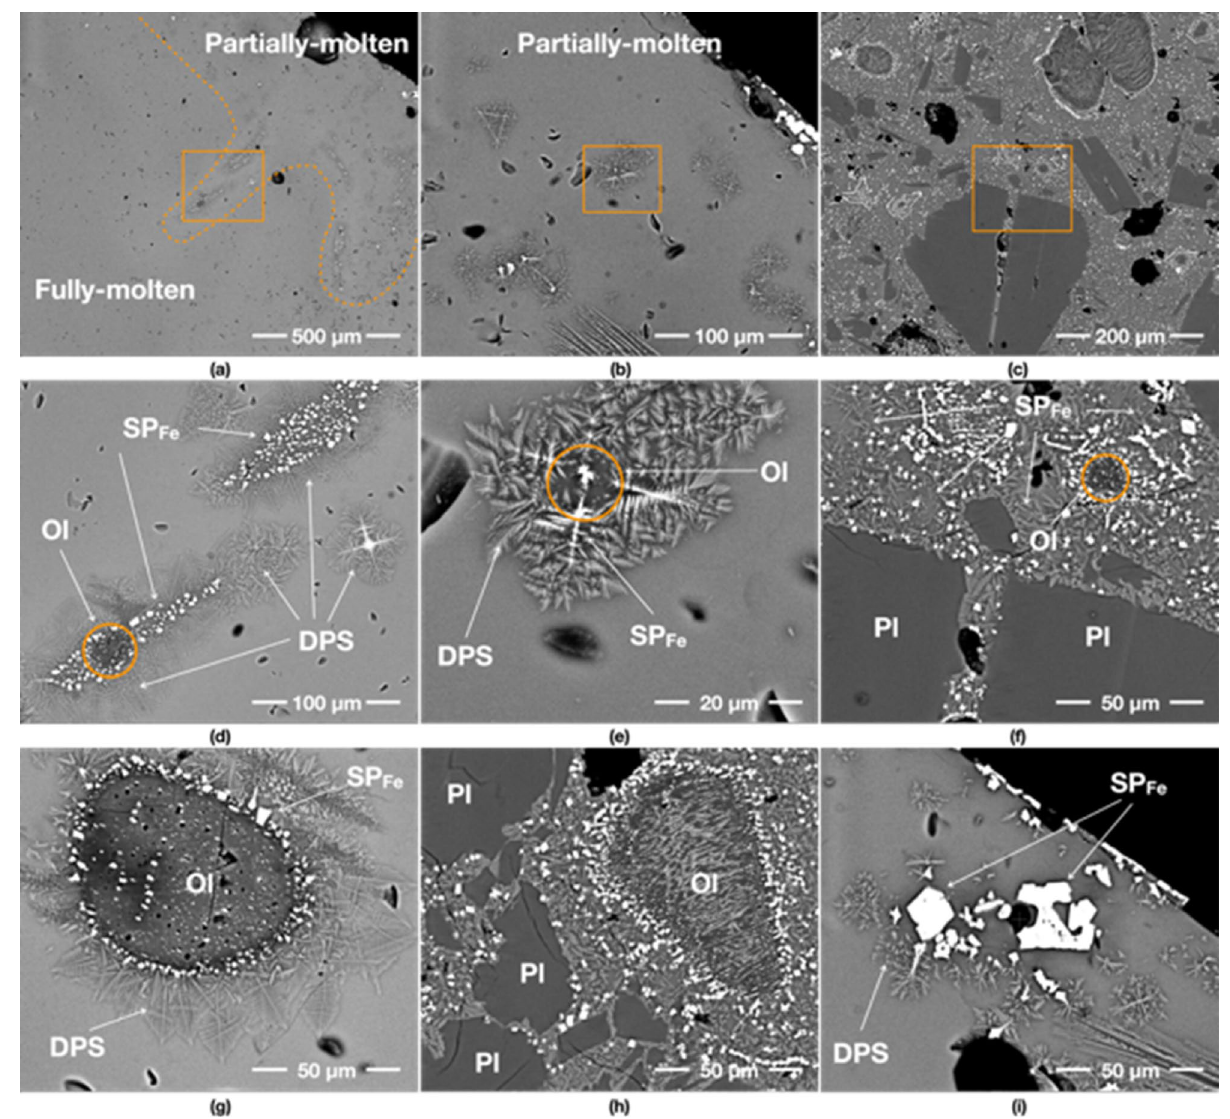
Figure 4. BSE images of 600 W specimen. ( a – c ) show an overview of its fully-molten, partially-molten, and sintered areas. ( d ) is the detail of the box in ( a ) indicating the olivine (Ol) is reacting with glass melt, and then formed dendritic patterned silicates (DPS) and rectangular-shaped SP Fe particles. ( e ) is the detail of the box in ( b ) presenting another example of the olivine (Ol) reaction forming SP Fe particles. ( f ) is the detail of the box in ( c ) showing abundant DPS and rectangular-shaped SP Fe particles in the glassy matrix. ( g ) from a partially molten area. ( h ) from a sintered area shows that SP Fe particles are exsolved from olivine grains with distinctive inner patterns, indicating that both grains may have undergone the same chemical processes with different peak temperatures and cooling rates. ( i ) shows unusually large SP Fe particles formed in a partial-molten glassy specimens and may indicate a lower efficiency of microwave heating below 600 W of input power, caused by much longer heating times. Thermal runaway and the temperature curves. Unlike the observation of Liu and Sheen 11 , who con- cluded that thermal runaway has an input power threshold, it was observed in our previous simulation 14 that thermal runaway occurs when the temperature of the lunar soil exceeds 620–700 °C, regardless of the input power. This temperature is close to the glass transition temperature of the JSC-1A powder (665–695 °C 23,24 ). The experimental results presented here found that even the 400 W and 250 W specimens experienced thermal runaway despite their lower peak temperatures and slower temperature increase. This corroborates the simula- tion results and suggests that temperature is the key threshold for thermal runaway, and not the input power (although higher input power allows an individual specimen to experience thermal runaway sooner than those at lower input powers).